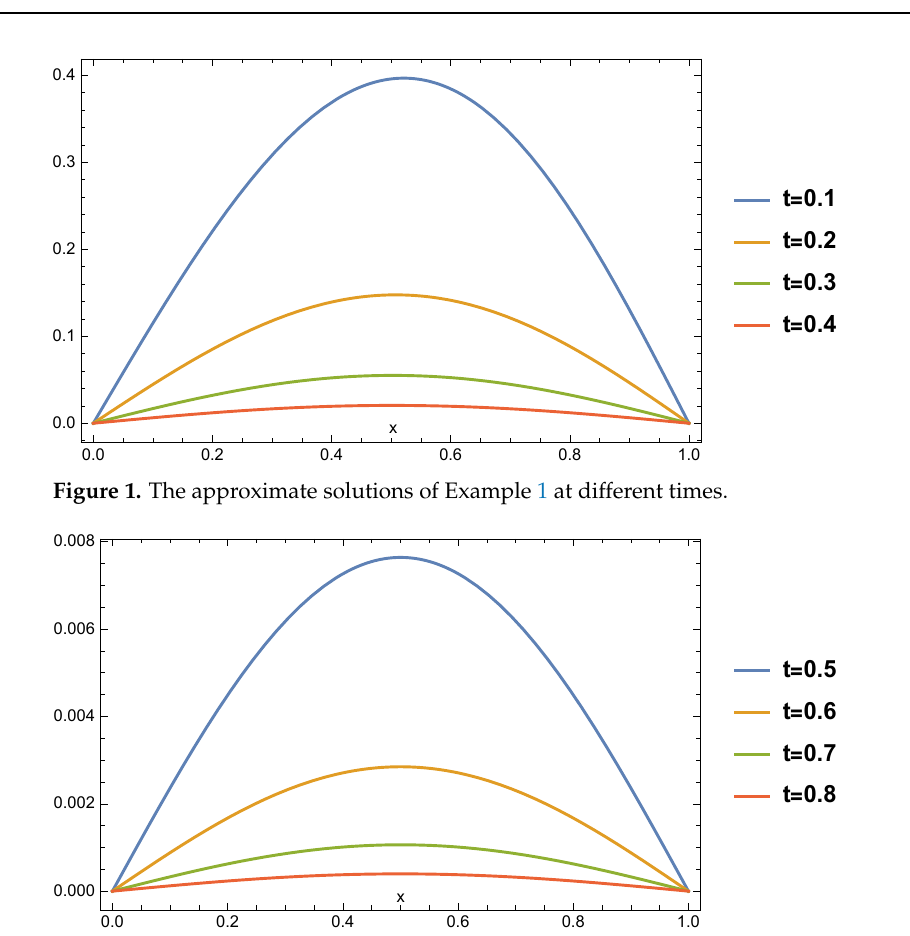
Figure 2. The approximate solutions of Example 1 at different